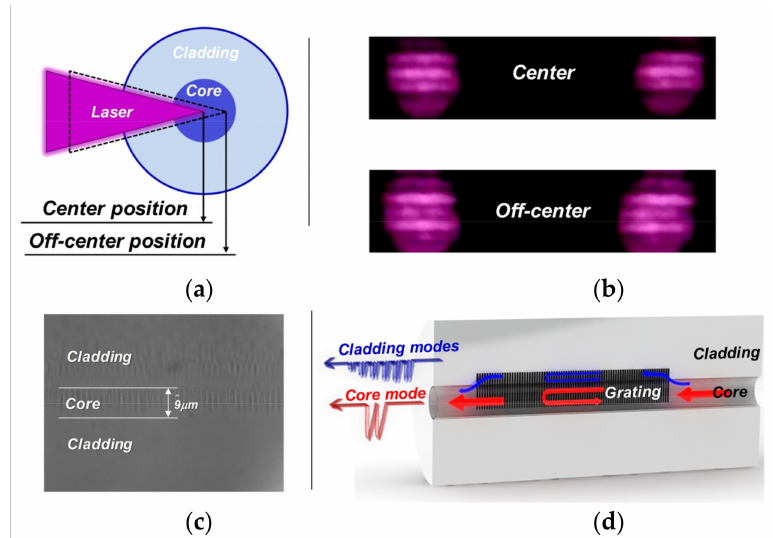
Figure 1. ( a ) Schematic of the focused point inside the fiber; ( b ) di ff raction patterns of the laser after passing through the fiber core for focused beam and defocused beam; ( c ) longitudinal photomicrograph of grating; ( d ) schematic of